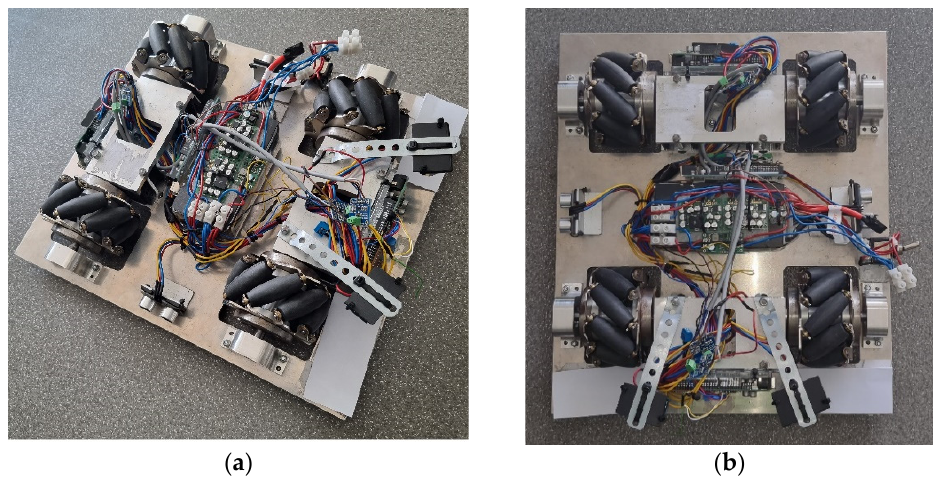
Figure 1. The mobile robot with Mecanum wheels: ( a ) first view; ( b ) second view. Each wheel can be actuated independently using DC motors commanded through variable-width voltage pulses, by means of the pulse with modulation (PWM) method. DCX 22 L DC motors from Maxon (Maxon Motor AG, Sachseln, Switzerland) were used as the actuation motors. Two Arduino Mega 2560 boards (Arduino AG, Italy) were used to handle the generation of the variable-width voltage pulses for the actuation mo- tors. Two motor drivers dual, VNH5019, were used to command the drive motors of the wheels (Pololu, Las Vegas, NV, USA).